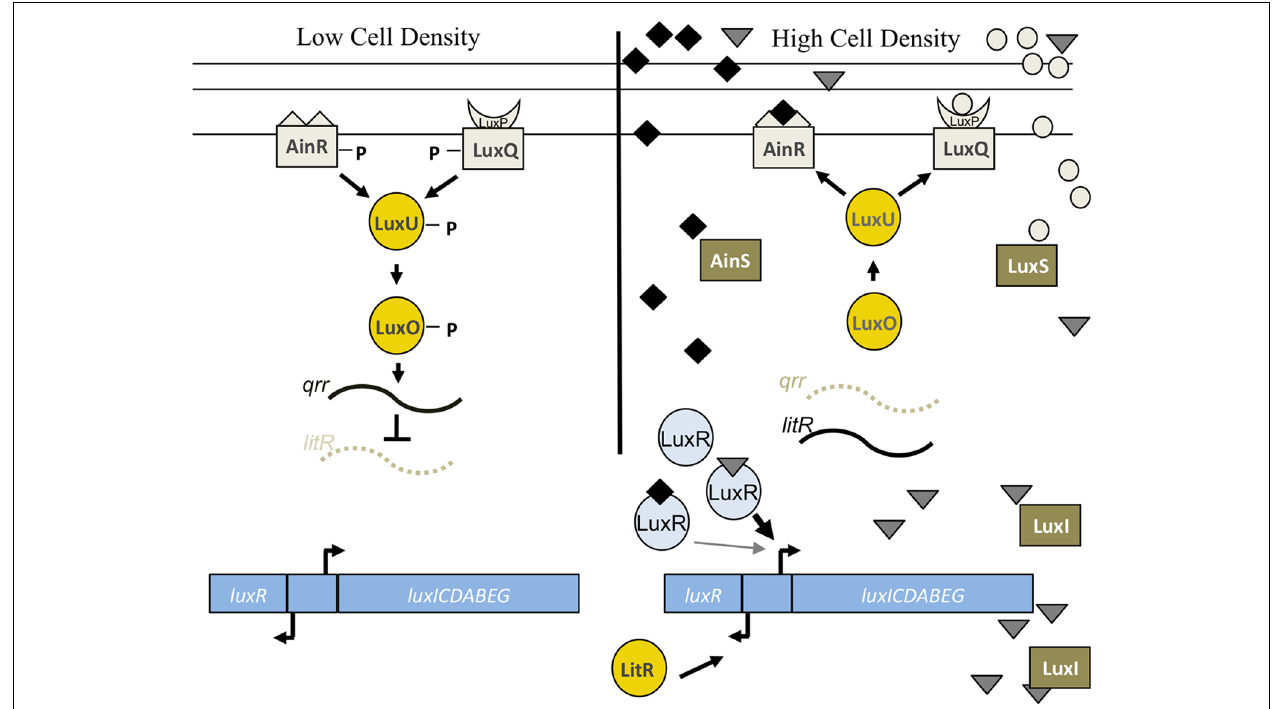
AinS (C8-HSL, diamonds) and LuxS (AI-2, circles) are predicted to be at sufficient concentrations to switch the activity of the SKs from net kinase to net phosphatase activity.This leads to dephosphorylation of the downstream regulators, litR translation, and transcription of luxR . LuxR, in conjunction with the autoinducer produced by LuxI (3-oxo-C6-HSL, triangles), leads to the transcription of the lux operon and bioluminescence (reviewed in Stabb etal., 2008). LuxR is also predicted to weakly bind to C8-HSL, which allows for the initiation of luxCDABEG expression. See text for caveats to this